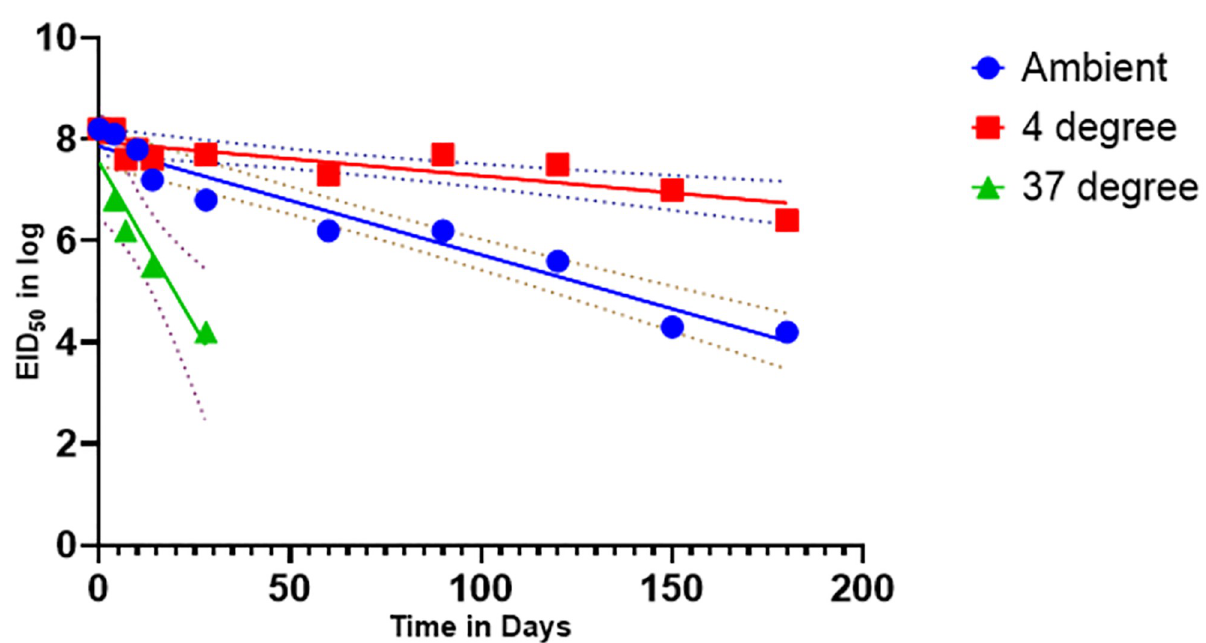
Fig 8. Ranigoldhunga ™ vaccine stability tested at different temperature within a range of relative humidity (40–60%). Ambient temperature (blue) ranging from 20–25˚C, 4 ˚C (red) and 37 ˚C (green) were three different temperatures the vaccine was tested for. Recorded stability at EID 50 is represented by the solid lines, and plotted stability (CL- 95%) derived from a mean value calculation is shown with the dotted lines.